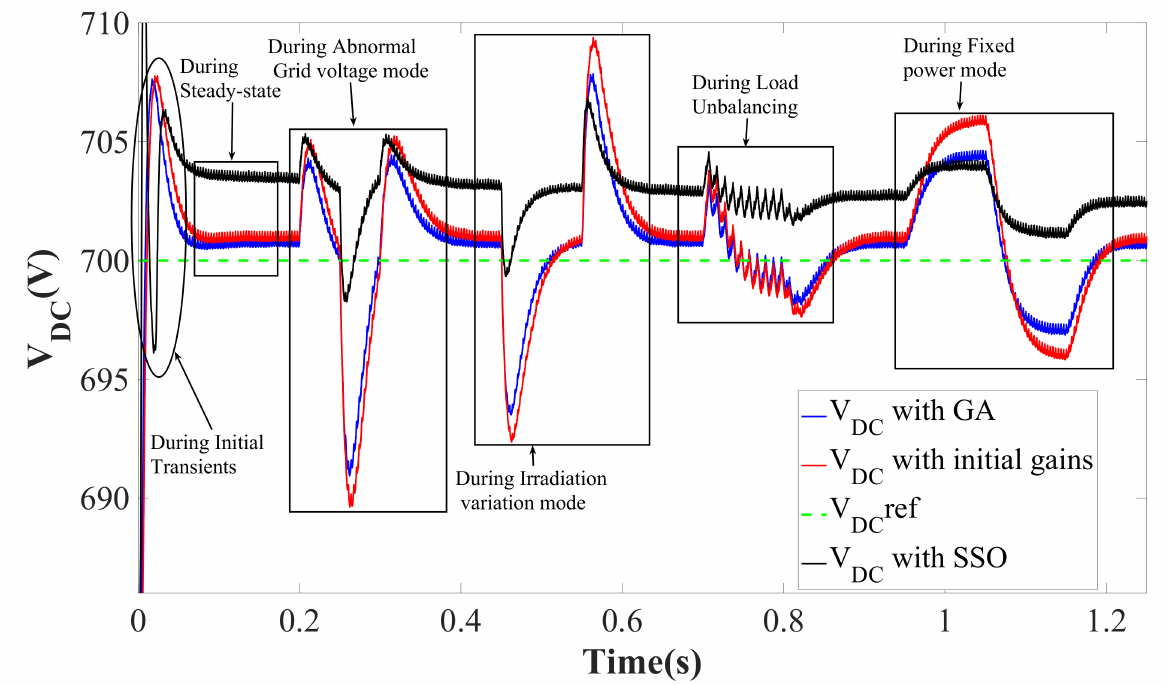
Figure 14. DC link voltage variations during various induced dynamic